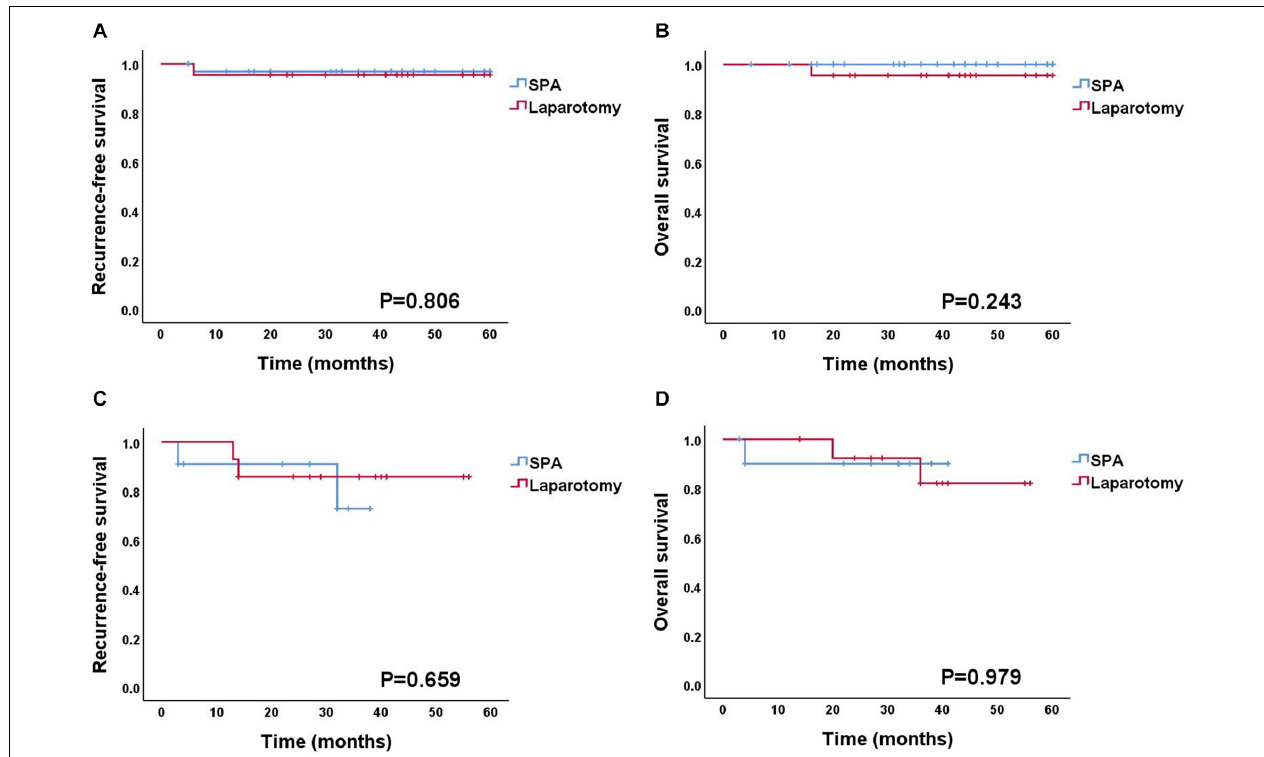
FIGURE 2 | Survival outcomes according to the surgical approach. (A,B) Recurrence-free survival and overall survival for BOT patients. (C,D) Recurrence-free survival and overall survival for OC patients. BOT, borderline ovarian tumor; OC, ovarian cancer.